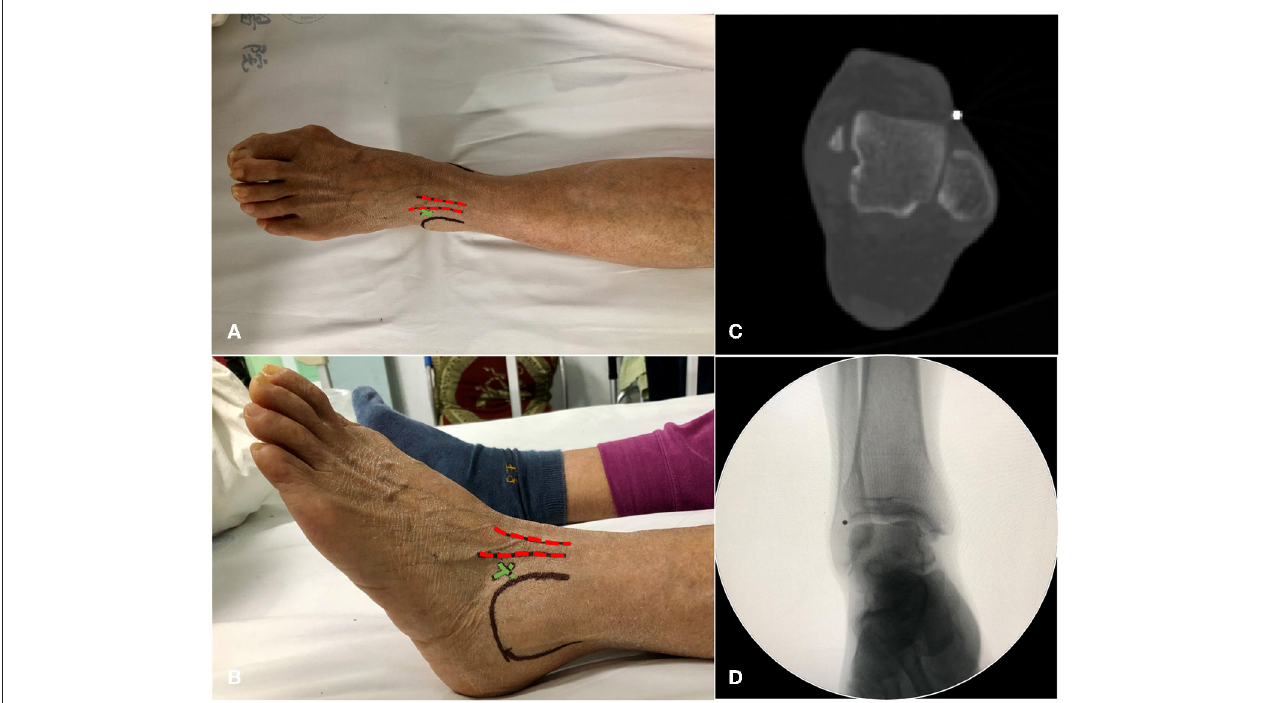
FIGURE 3 | Schematic diagram of LDAT positioning. (A,B) Top and left views. Red dotted line, the extensor digitorum longus tendon; green cross, the LADT position; black circle, the malleolus lateralis. (C,D) Positioning LADT with a steel ball on the body surface, CT axial plane image and X-ray fluoroscopy image.